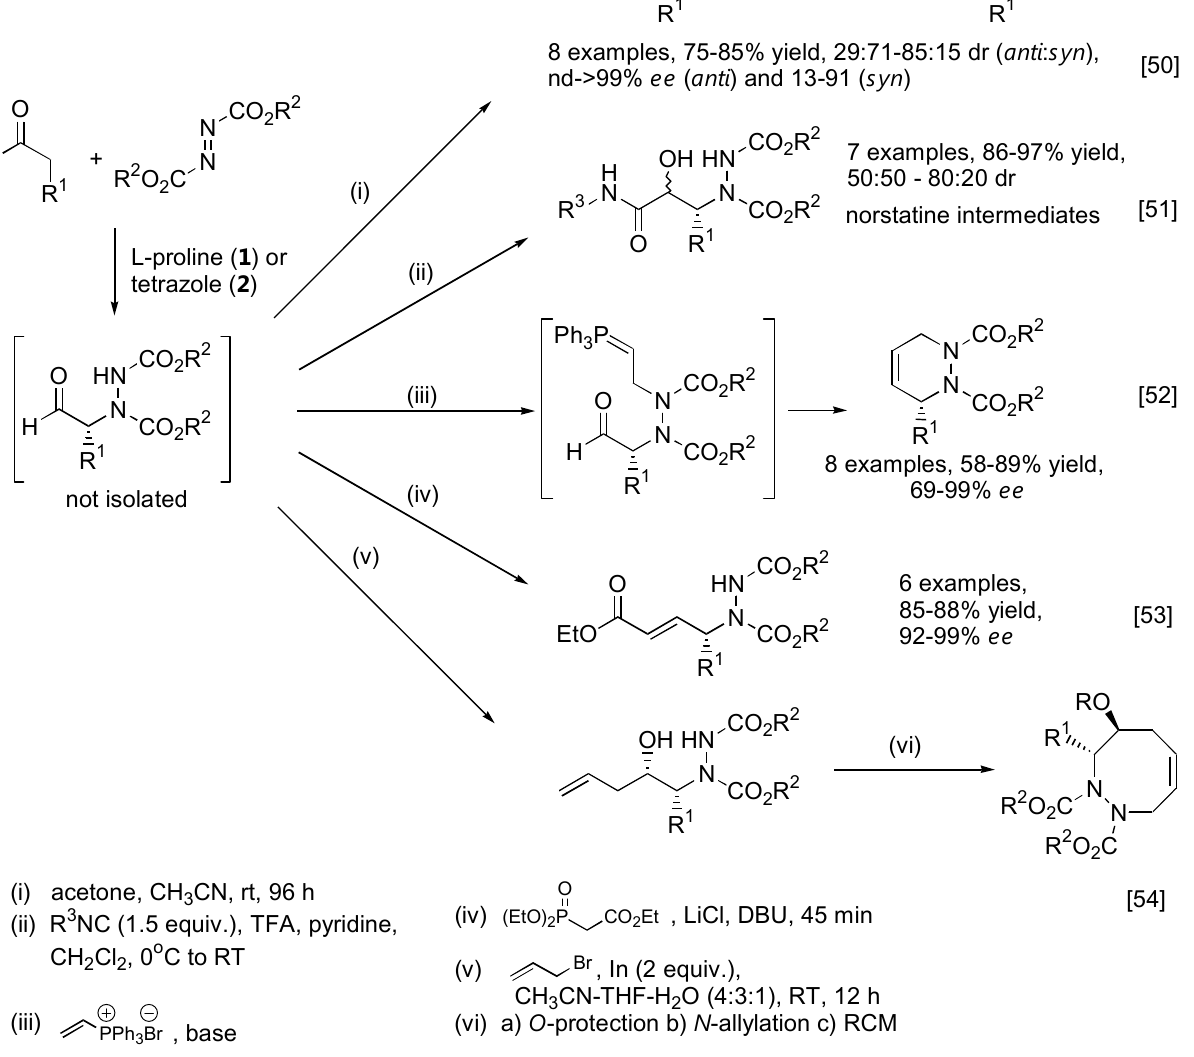
8 examples, 75-85% yield, 29:71-85:15 dr ( anti : syn